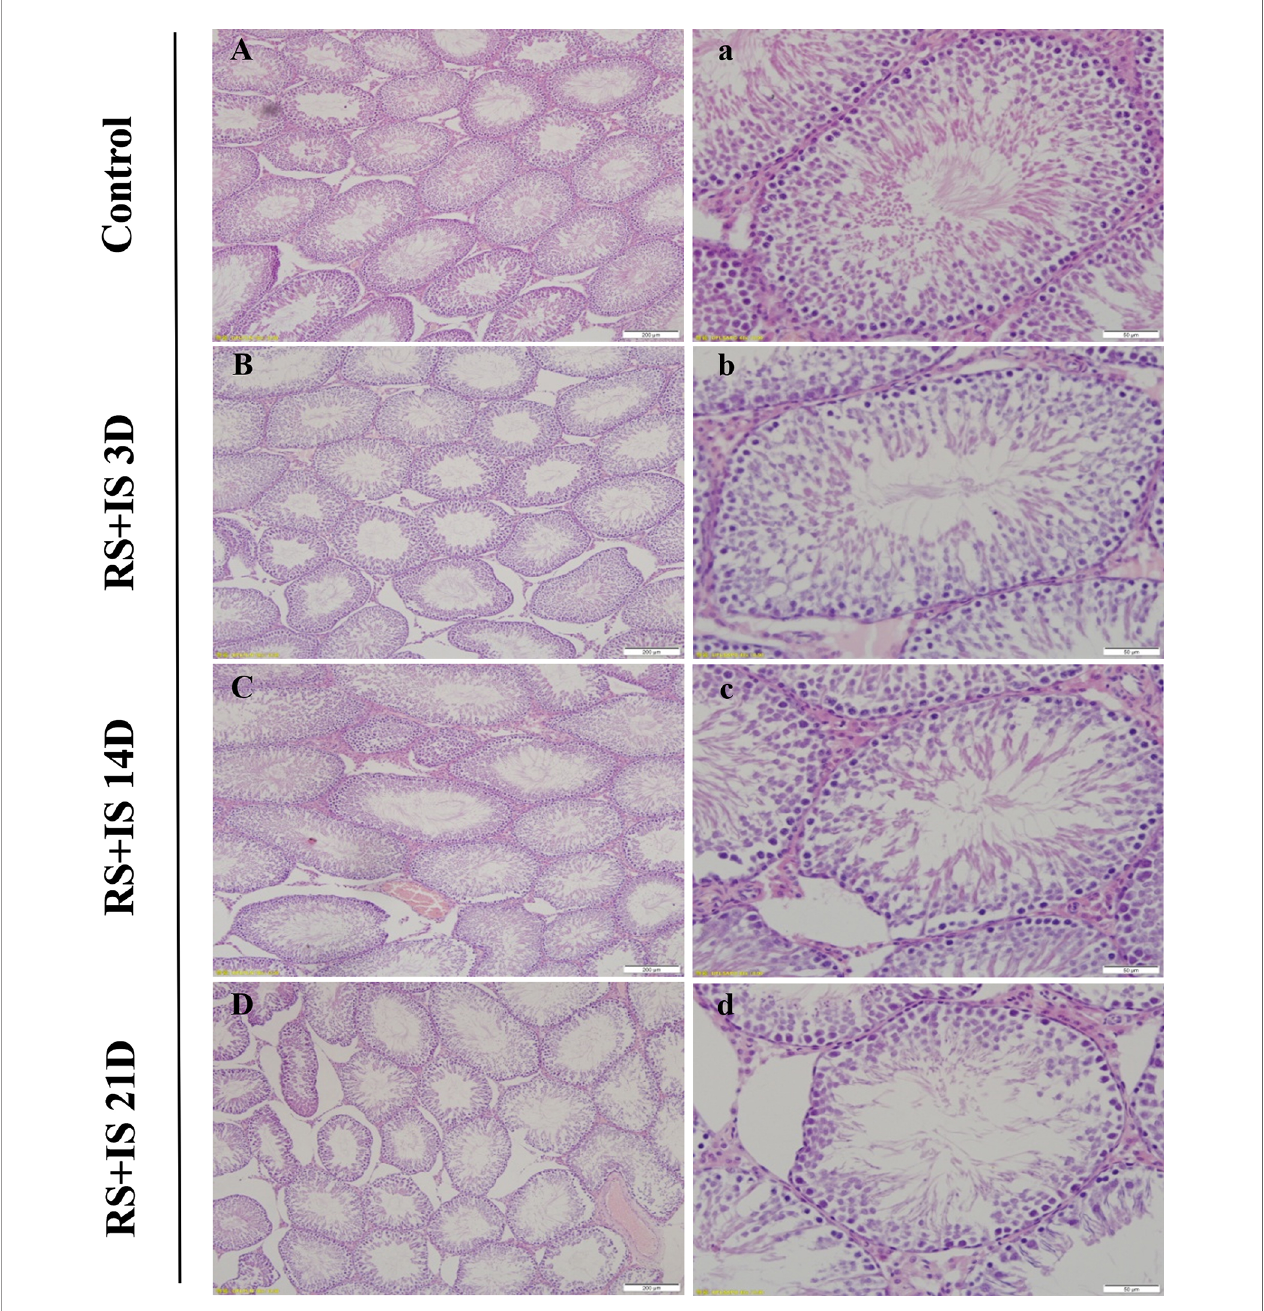
FIGURE 1 | HE staining of the testis. The seminiferous tubules were regular in shape and orderly in arrangement in the control group (A, a) and RS+IS group at 3 days (B, b) . The tubule basement membrane was separated from spermatogenic cells after 14 days RS+IS exposure (C, c) . After 21 days of RS+IS exposure, pathologic changes of the seminiferous tubules were more obvious (D, d) ; Bars = 200 m m in (A – D) ; Bars = 100 m m in (a – d)